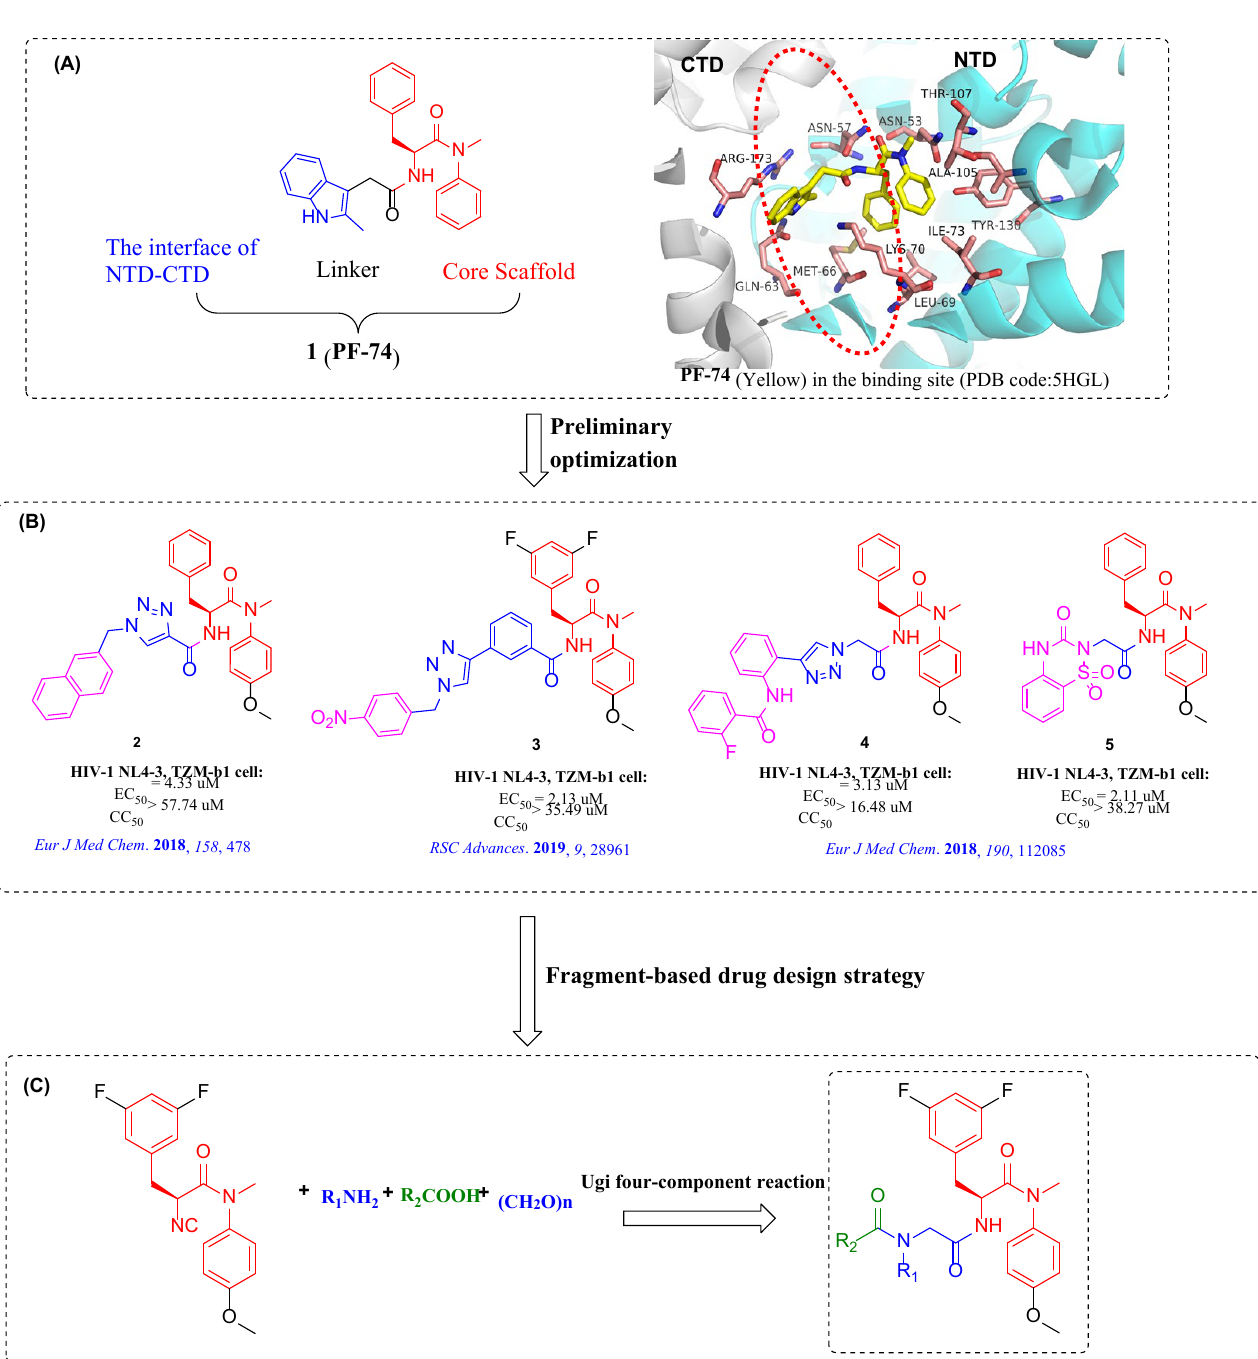
Figure 1. The design of novel phenylalanine derivatives HIV CA modulators ( A ) Structure and the binding mode of PF-74 within the NTD-CTD interface of an HIV-1 CA hexamer (PDB code: 5HGL). ( B ) Overview of reported phenylalanine derivatives from our group targeting the HIV-1 CA protein. ( C ) Schematic route for our Ugi four-component reaction strategy.